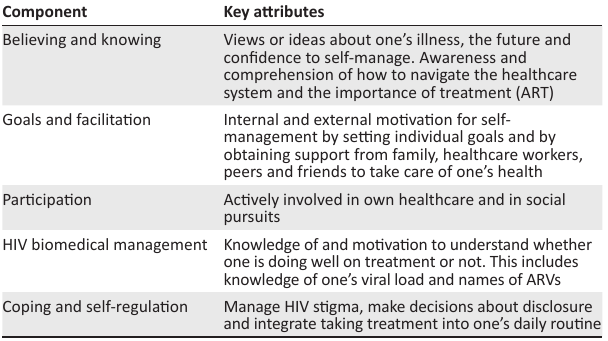
TABLE 1: Attributes of key components of adolescent HIV self-management. 22